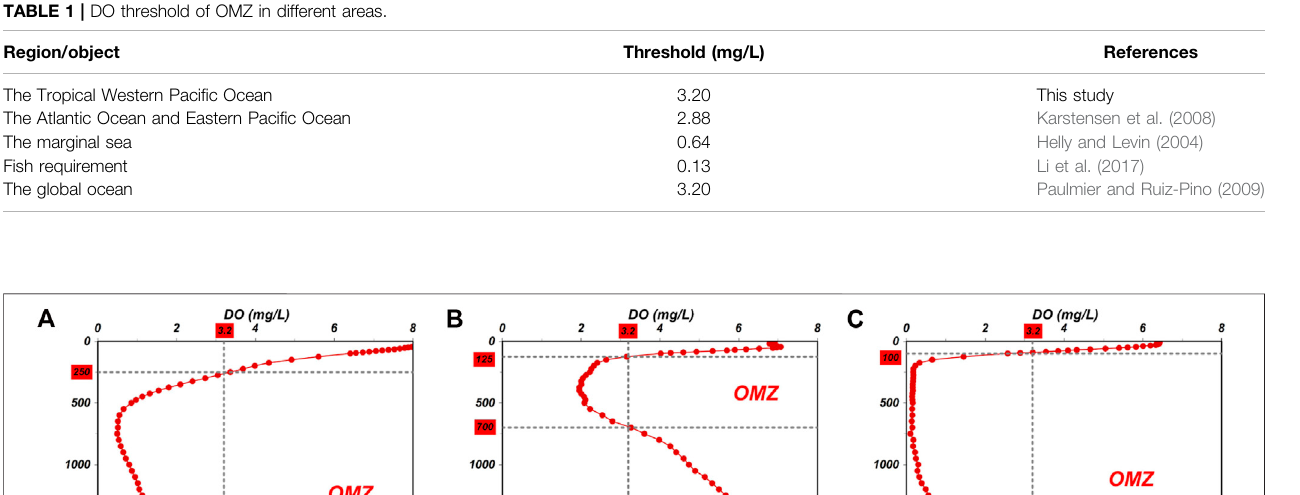
Frontiers in Earth Science |